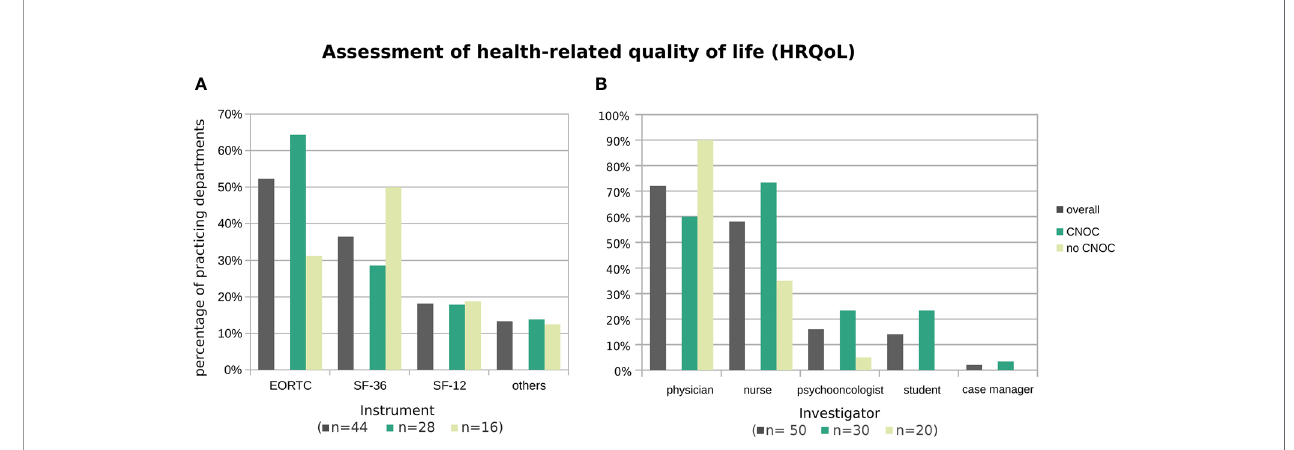
FIGURE 4 | Practiced HRQoL assessment instruments (A) and administering professionals (B) , overall and strati fi ed by CNOC af fi liation. Histograms are based on replies from n departments practicing assessment of HRQoL (with n provided by subgroup in the x-axis label). Multiple instruments (or multiple types of professionals) were named by 27% (30%) of departments. Other instruments (all named once) were the Functional Assessment of Cancer Therapy [FACT; (11)], the 5-level EQ-5D version [EQ-5D-5L; (12)], the Hornheider Screening Instrument (HIS; (9) cf. Assessment of psycho-oncological burden, depression, and anxiety), the Barthel Index (13), the Aachen Life Quality Inventory [ALQI; (14)], and an unspeci fi ed instrument developed by the respective department.